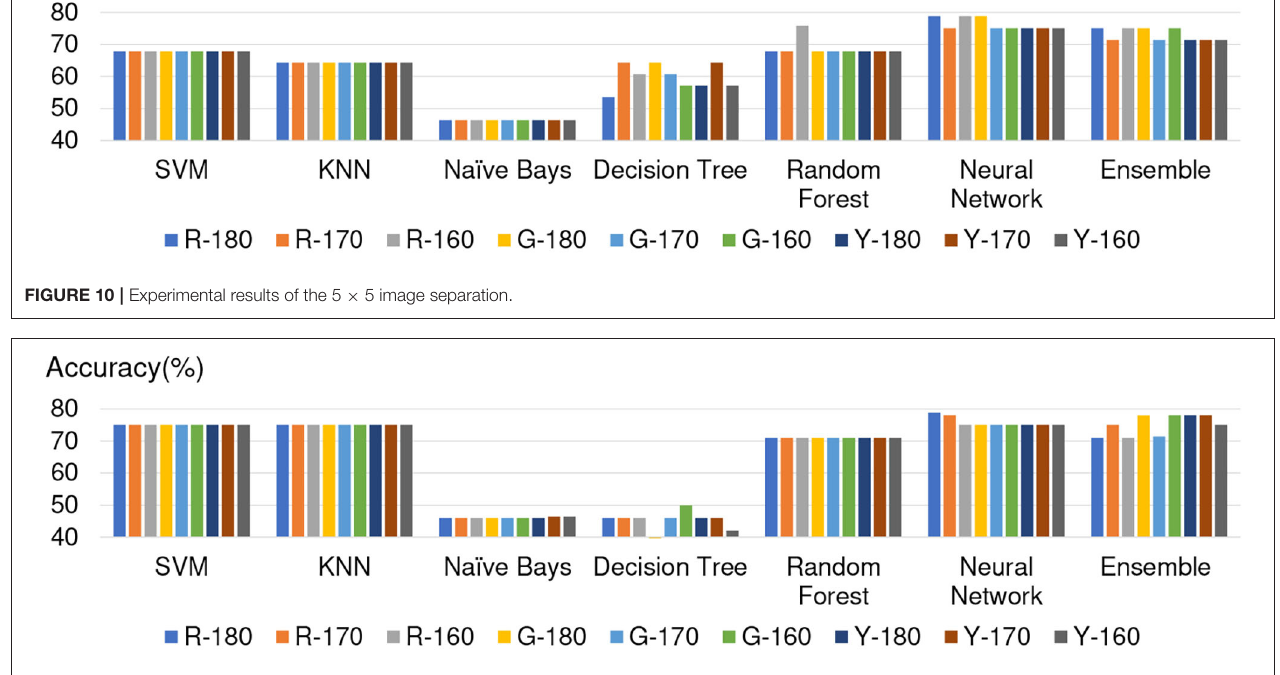
FIGURE 11 | Experimental results of the 4 × 5 image